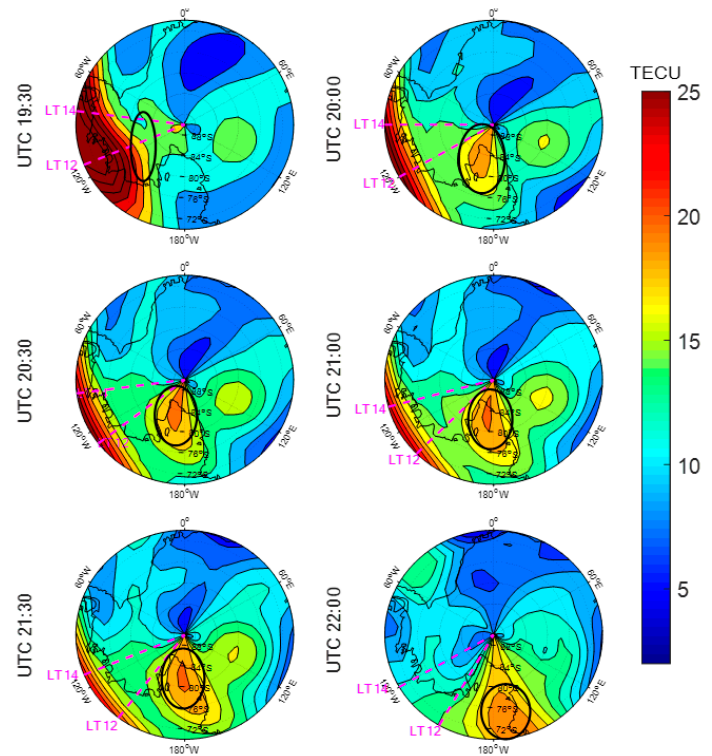
Figure 17. Antarctic ionospheric TEC mapping at UTC (Universal Time Coordinated) from 19:30 to 22:00 on the DOY 076 in 2015. The black ellipses in each subplot highlight the ionization patches.